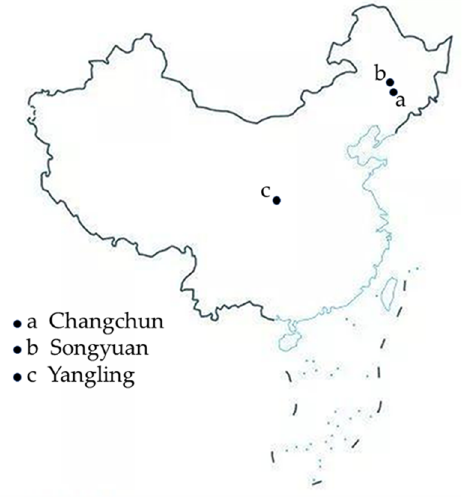
Figure 5. Location of field decomposition tests.